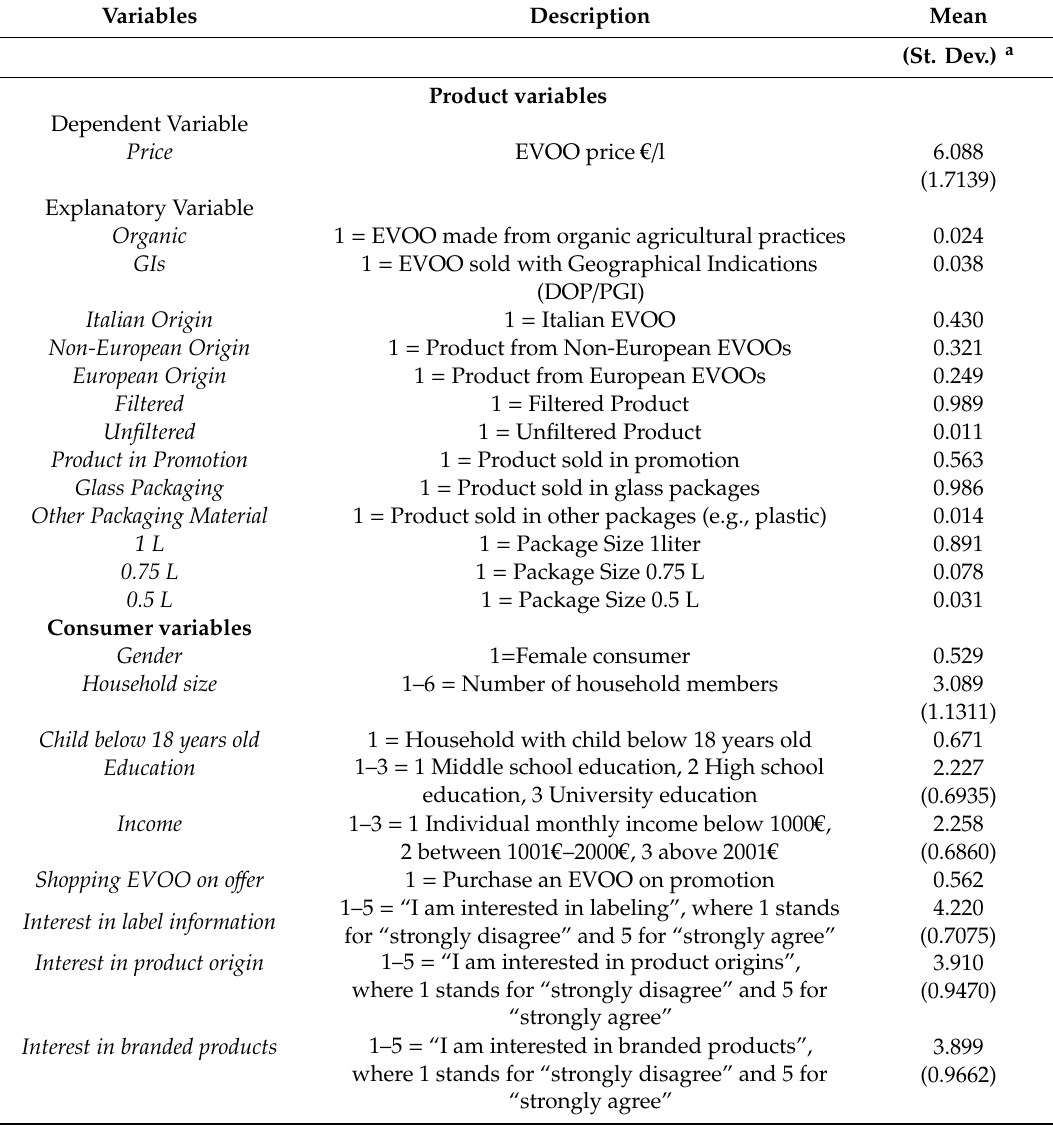
Table 1. Summary statistics related to product and consumer characteristics (982